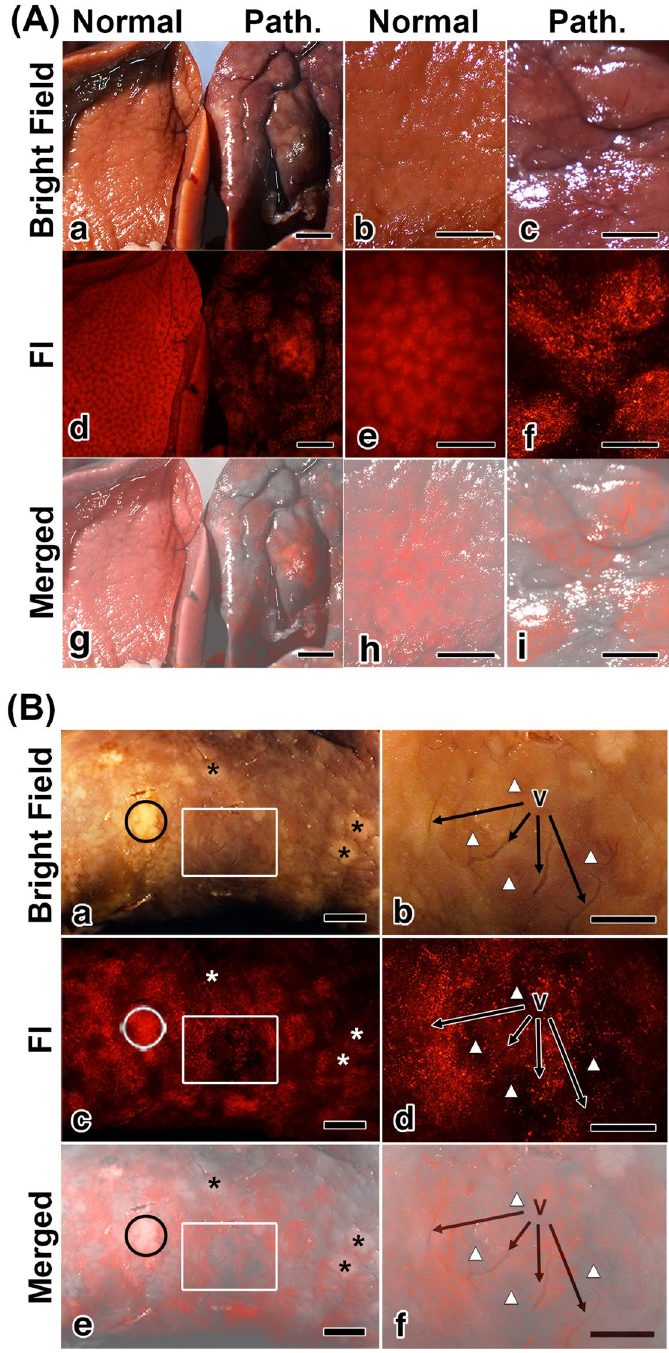
Figure 3. Mesoscopic FI of a pathological liver of LEC rat. ( A ) Normal (a,b,e) and pathologic (Path.) (a,c,f) liver were observed on bright field (a–c) and FI (d–f). Normal liver showed a fluorescent reticular hepatic lobular pattern (d and e), but the pathologic liver did not (d and f). Panels (g),(h) and (i) are merged images of (a) and (d),(b) and (e) and (c) and (f), respectively. Scale bars: (a,d,g) 2 mm, (b,c,e,f,i) 1 mm. ( B ) The pathologic liver was observed with higher magnification. There were white nodules marked with asterisks and open circle in the bright field image (a). The surface of the pathologic liver showed a heterogeneous distribution of labeled cells in the FI (c). Panels (e) is merged images of (a) and (c). Areas indicated by a white box in panel (a,c,e) were observed with high magnification. Some vessels (V) were observed in the bright field image (b). Areas with a lower distribution of labeled cells (white triangle) were observed in FI (d). The merged image of (b) and (d) revealed that there were higher numbers of labeled cells around the vessels (V) than far from vessels (white triangle) (f). Scale bars: (a,c,e) 2 mm, (b,d,f) 1